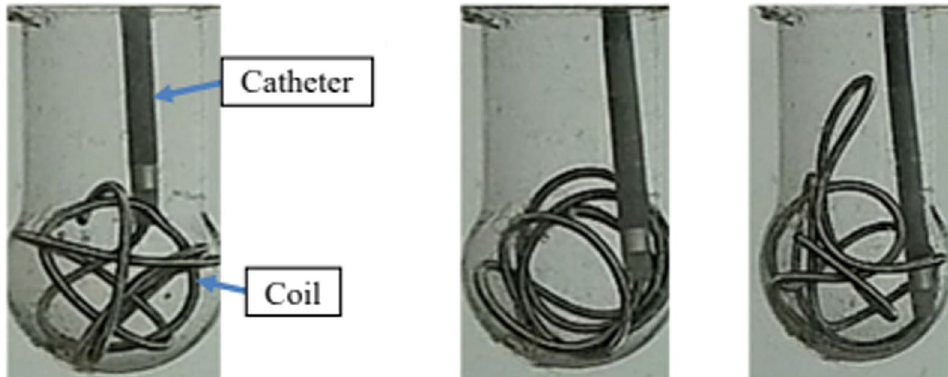
Fig. 1 Illustration for coil embolization in a rubber model [44]